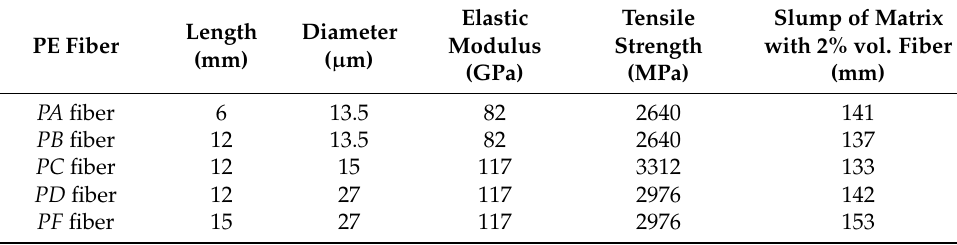
Table 4. Morphology and basic parameters of PE